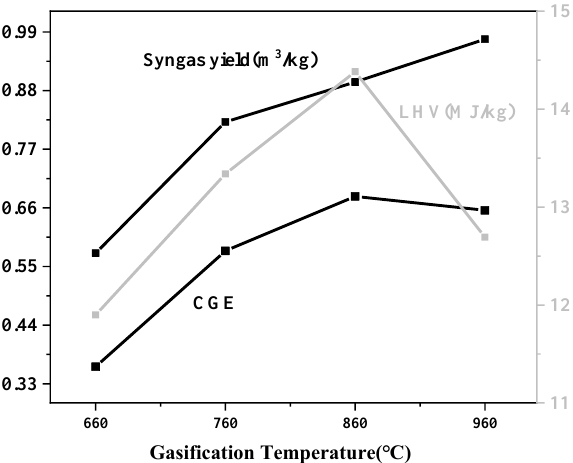
Figure 8. Effect of gasification temperature on LHV, syngas yield, and CGE. By integrating the experiment results obtained from different gasification temperatures, the higher quality syngas could be obtained from a temperature of 860 to 960 ◦